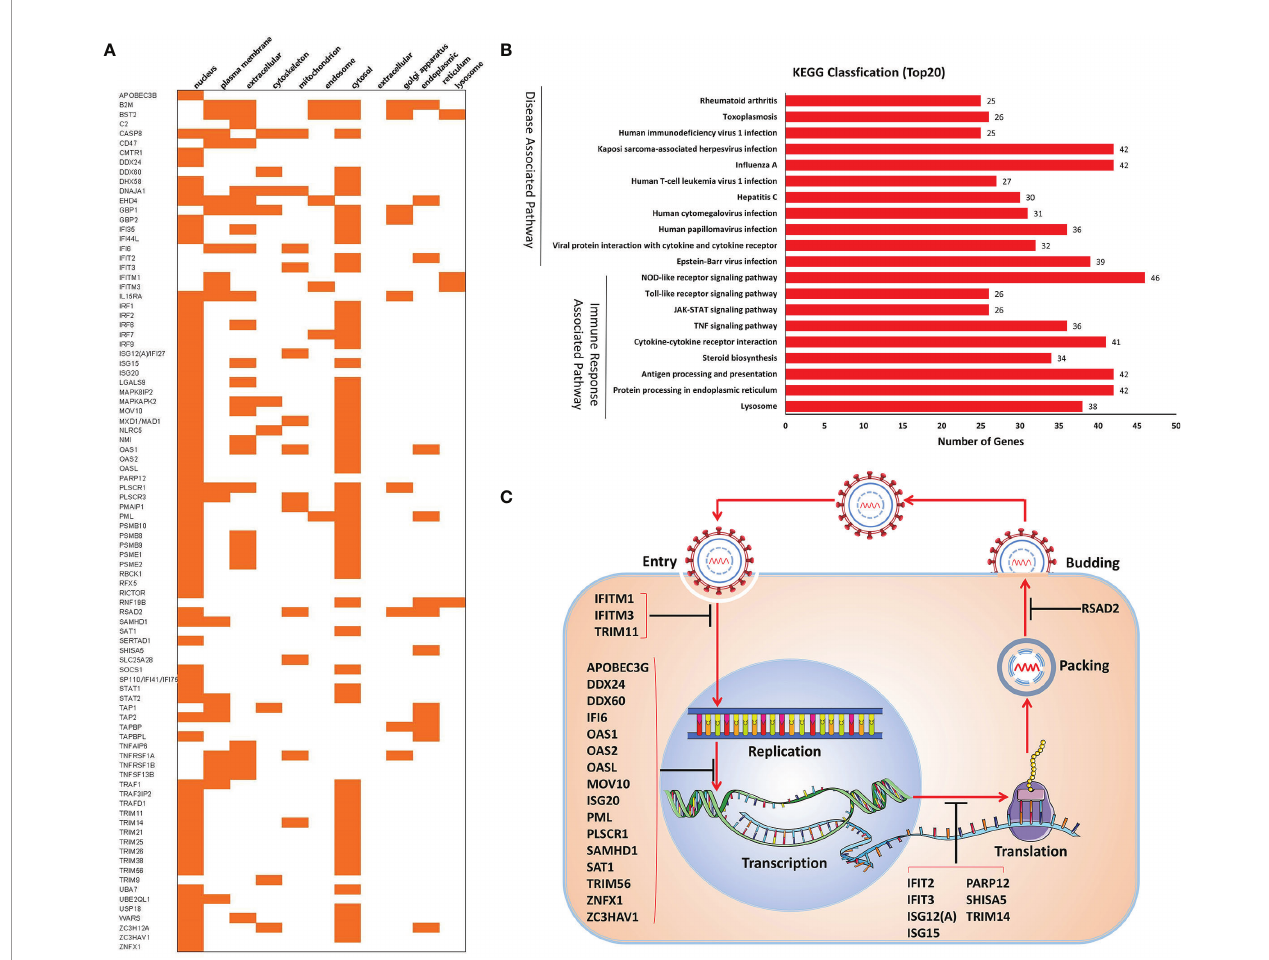
FIGURE 4 | Analysis of 90 ISGs. (A) Subcellular localization. (B) KEGG classi fi cation. (C) Antiviral activities of